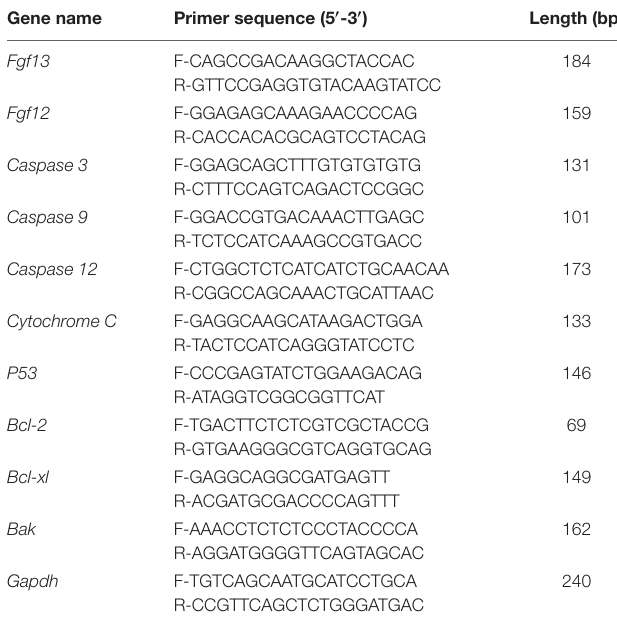
TABLE 1 | List of qRT-PCR primer